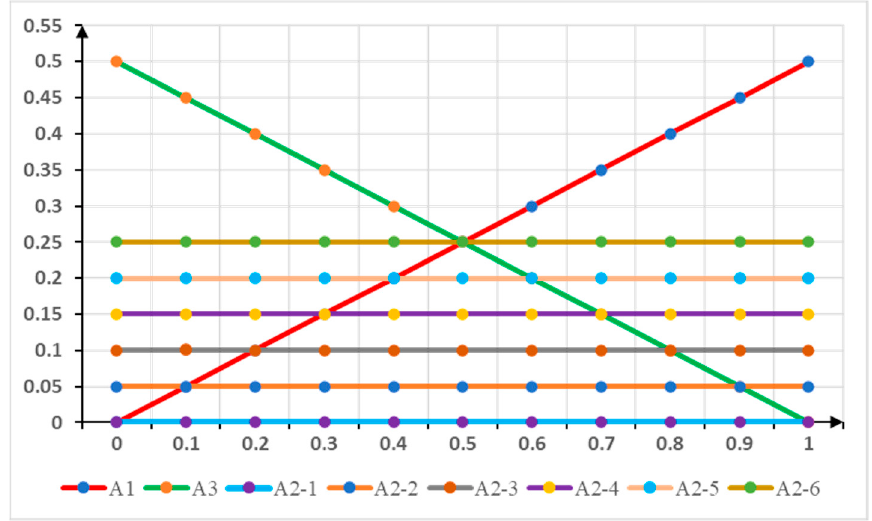
Figure 4. Loss value functions for A1, A2, and